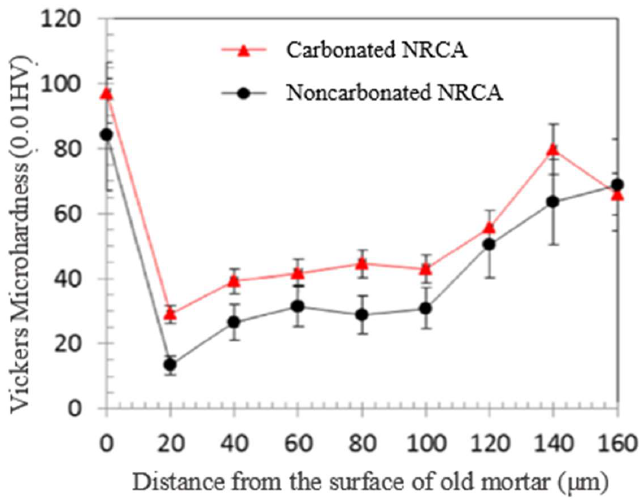
Figure 6. Vickers microhardness of new ITZs before and after treatment of NRCAs [37]. Reproduced with permission from [37], Elsevier, 2016.